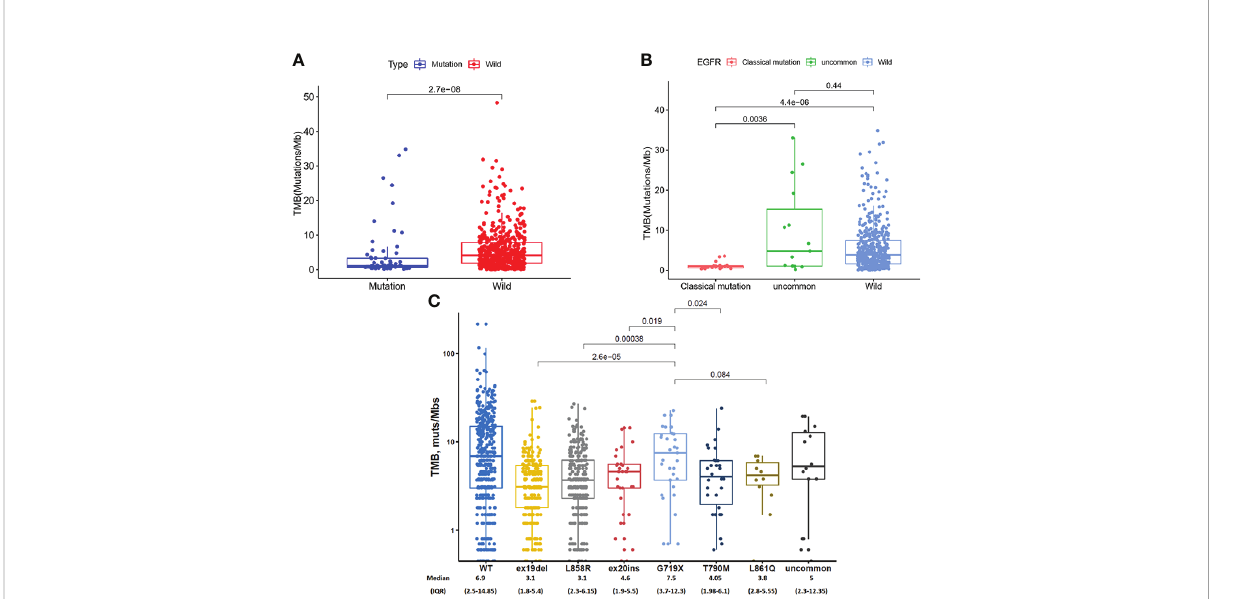
FIGURE 3 TMB in TCGA database (A, B) and clinical center (C) . (A) Comparison of TMB in NSCLC patients from TCGA database between EGFR wild-type and EGFR-mutated groups. (B) Comparison of TMB in NSCLC patients from TCGA database between EGFR classical mutations, uncommon mutations, and EGFR wild-type groups. (C) The expression of TMB in patients with different EGFR mutations in our clinical